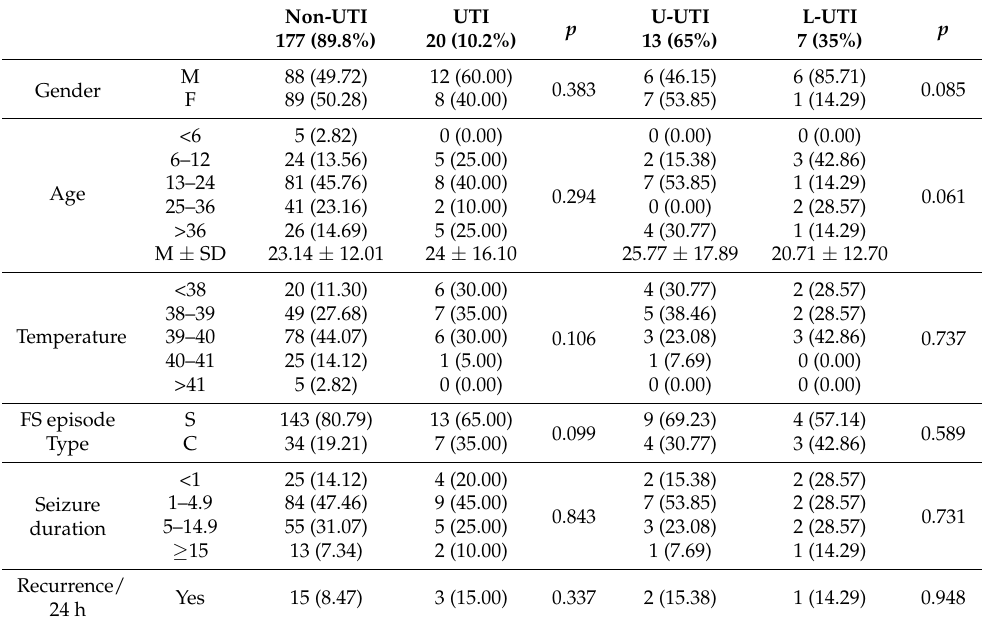
Table A1. Description of the demographic and clinical data.